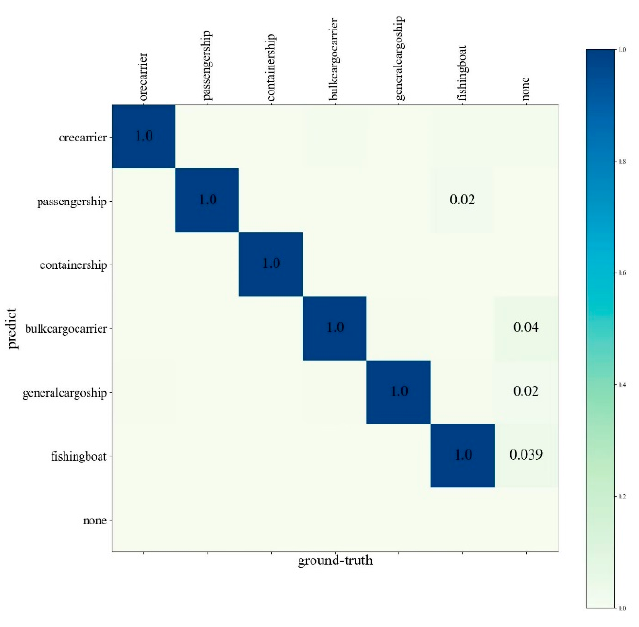
Figure 9. Confusion matrix of CBAM-YOLOX network detection results.